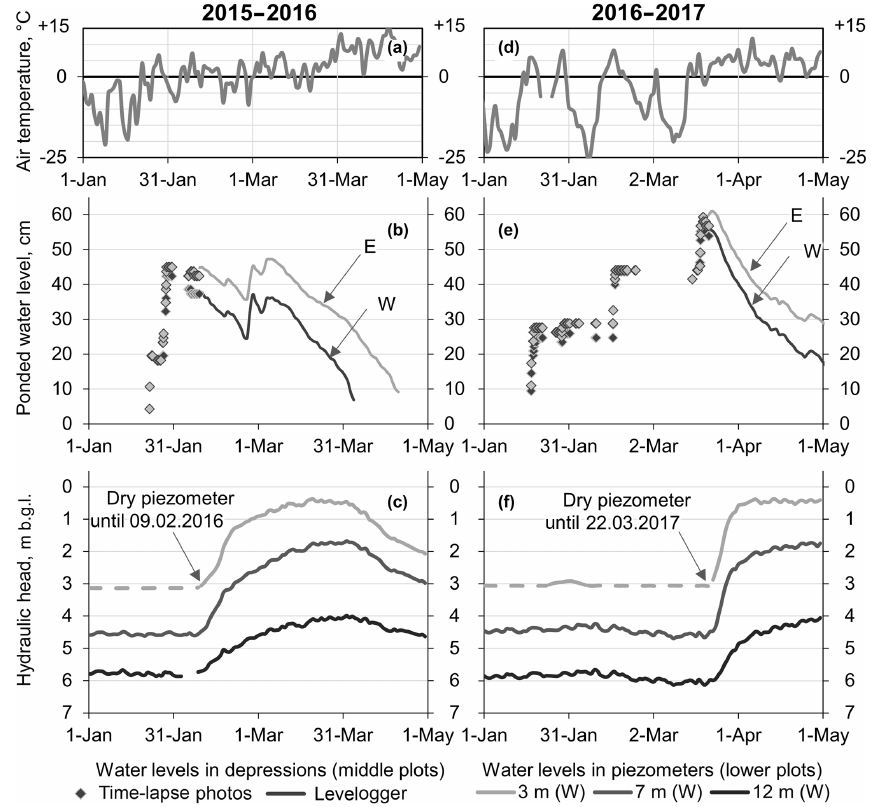
Figure 9. Daily average air temperatures (a, d) , water levels in the depressions (b, e) , and piezometers (c, f) at the Triple G site in winter 2015–2016 (a, b, c) and 2016–2017 (d, e, f) . b.g.l. – below ground level. W and E refer to the two adjacent depressions as shown in Fig. 2.